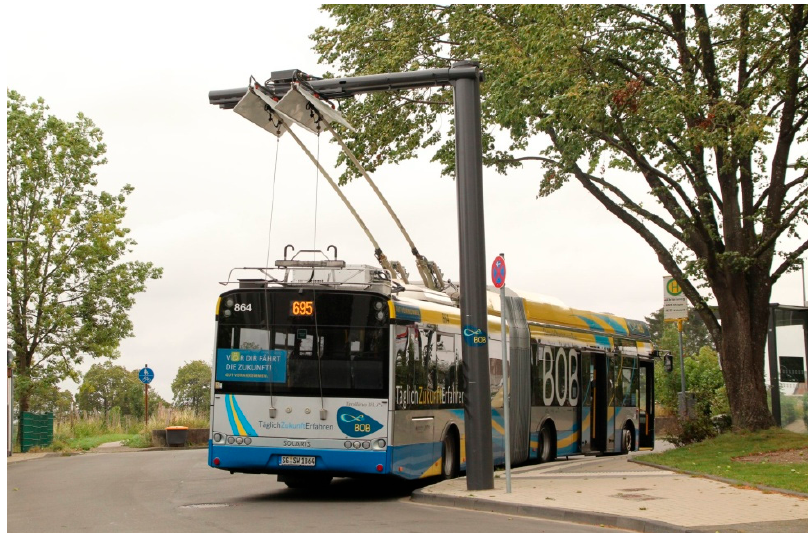
Figure 1. Trolleybus charging station in Solingen (photo taken by M. Bart ł omiejczyk).